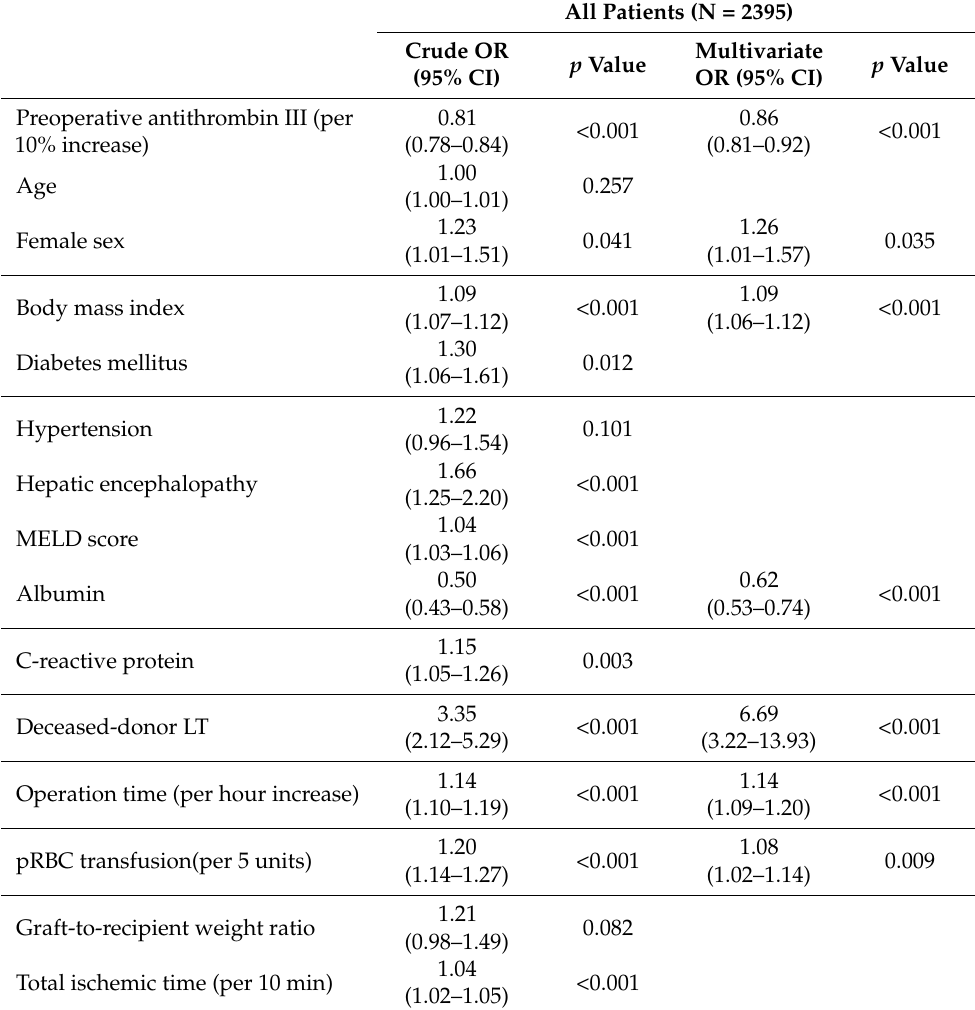
Table 3. Multivariate analysis of risk factors associated with postoperative acute kidney